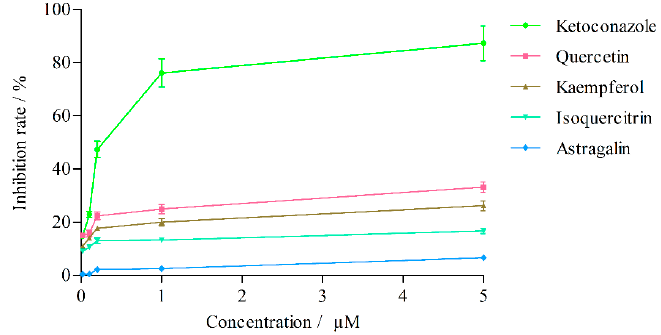
Figure 6. Effects of flavonoids on CYP3A4 isozyme activities.